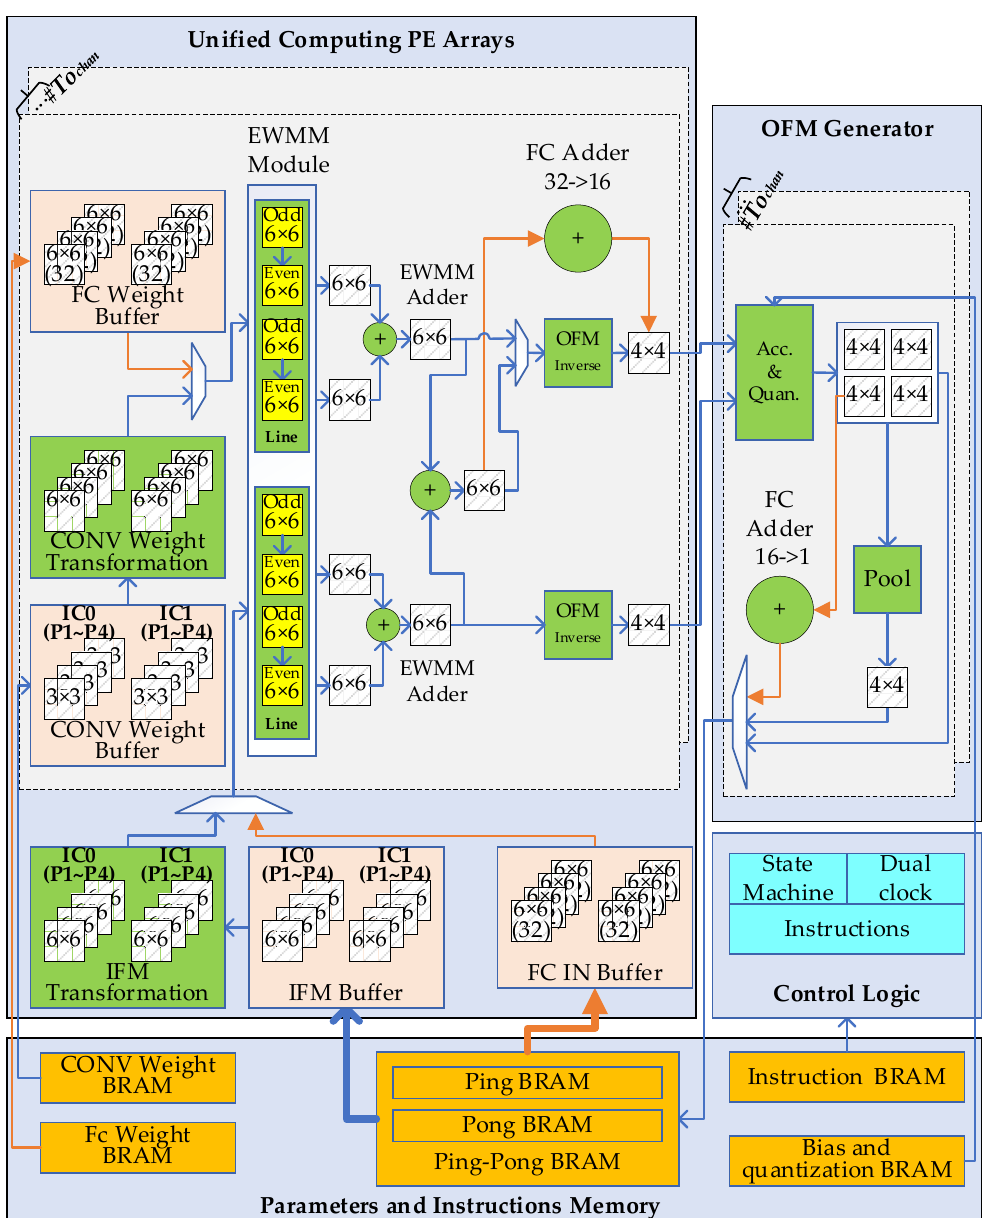
Figure 2. The architecture of the accelerator.